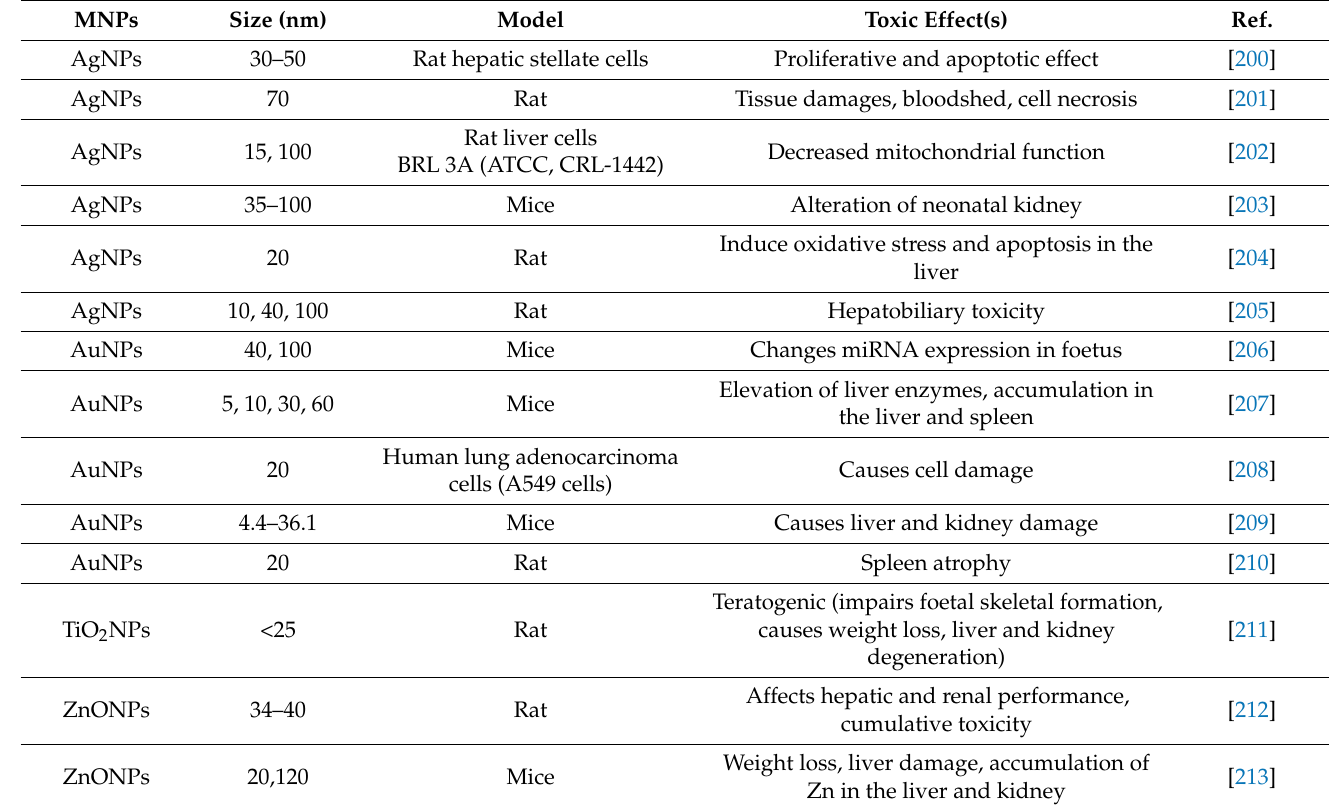
Table 4. Summary of MNPs that have been assessed for their biological safety using in vitro and in vivo